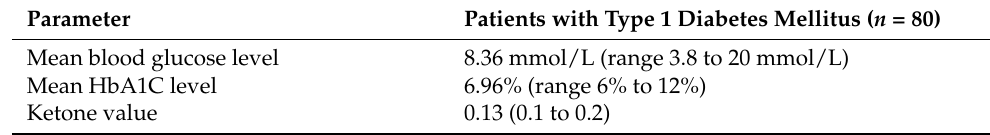
Table 2. Metabolic parameters of the university-based data evaluation.